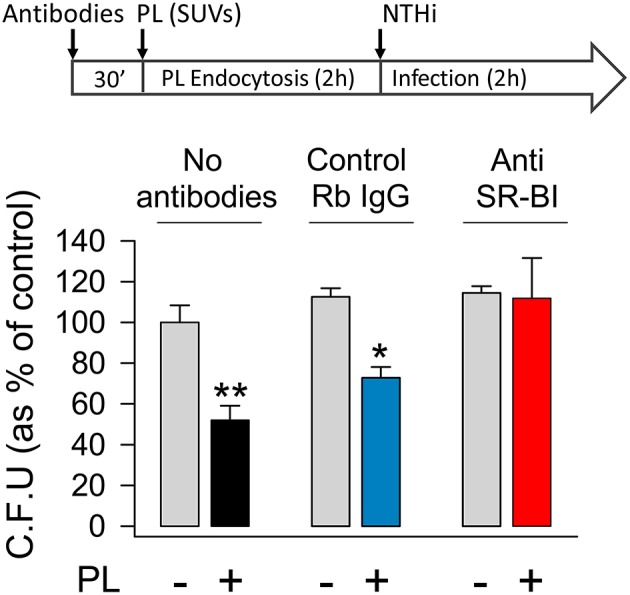
Blocking scavenger receptor SR-BI abrogates surfactant lipid inhibition of NTHi invasion. Mouse pneumocytes were preincubated with or without anti-SR-BI or control rabbit IgG antibodies for 30 min, followed by 2 h incubation with SUVs composed of a mixture of surfactant lipids (100 μg PL/ml). Then, cells were infected with otitis NTHi, and invasion experiments were performed. Bacterial invasion was quantified by colony counting, and results were expressed as percentage of C.F.U. relative to cells infected in the absence of lipids and antibodies. The percentages of C.F.U. obtained in cells infected in the absence of lipids were not affected by the presence or absence of antibodies (control IgG or anti-SR-BI). Mean ± SEM of two independent experiments done in duplicate are shown. ANOVA followed by the Bonferroni multiple-comparison test was used. *p < 0.05 and **p < 0.01 when compared with infected pneumocytes in the absence of surfactant lipids and antibodies.